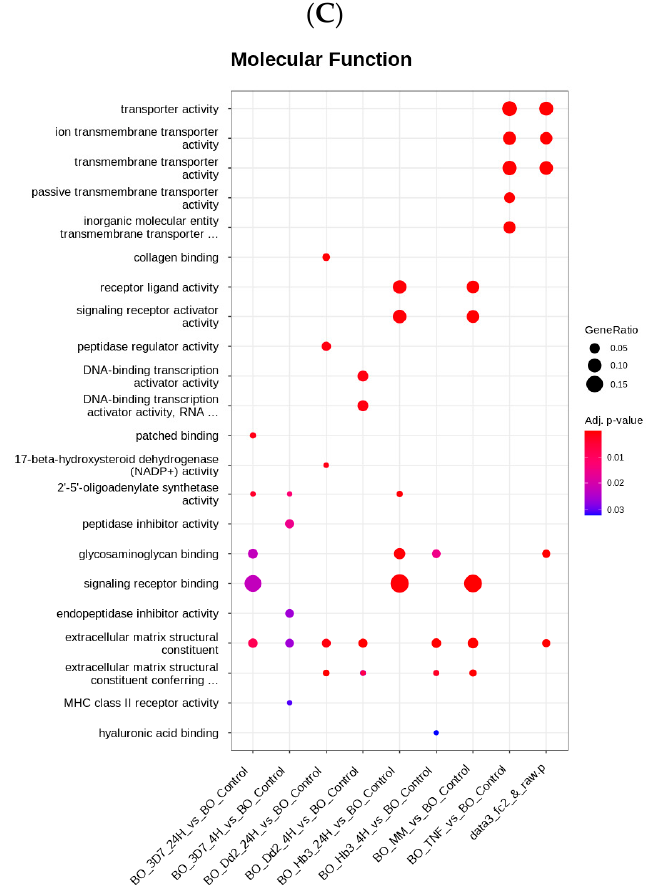
Figure 5. Gene Ontology (GO) from cerebral organoids transcriptomic. Dot plot shows significant Gene Ontology (GO). GO terms in each comparison were chosen if their adjusted p -value (adj. p -value) was less than 0.05. The top 10 GO terms are shown. The x-axis and y-axis were Gene Ratio (=intersection size/query size) and GO terms, respectively. Dot size was intersection size. Single-cell RNA sequencing (scRNA-seq) of cerebral organoids was performed after stimulation with secretome from P. falciparum-HBMEC. The transcriptomes analyzed were under several conditions, such as with TFN- α stimulation at time point from 4 h, which works as a positive control (BO_TNF), three different wild-type strains, 3D7, Dd2, HB3 of P. falciparum parasites induction, from 4 h (BO_3D7_4H, BO_Dd2_4H, BO_HB3_4H) and 24 h (BO_3D7_24H, BO_Dd2_24H, BO_HB3_24H), respectively. Cerebral organoids stimulated with the secretome from HBMEC without any stimulation named modified media (BO_MM). ( A ) Biological Processes ( B ) Cellular Component ( C ) Molecular function.